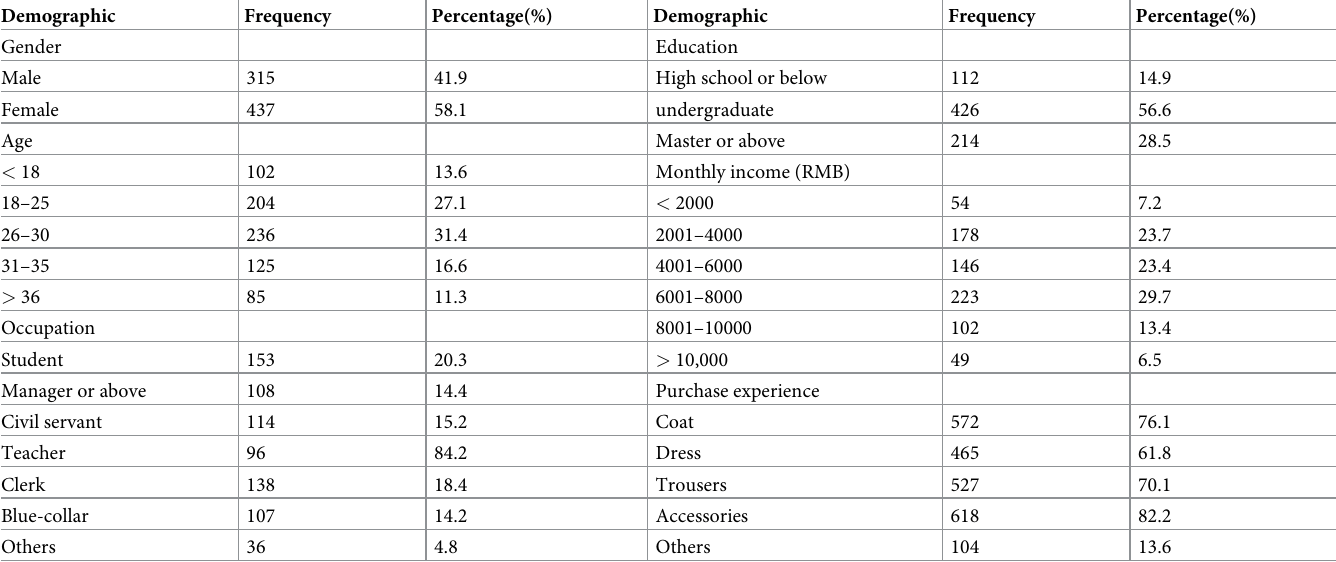
Table 1. Consumer